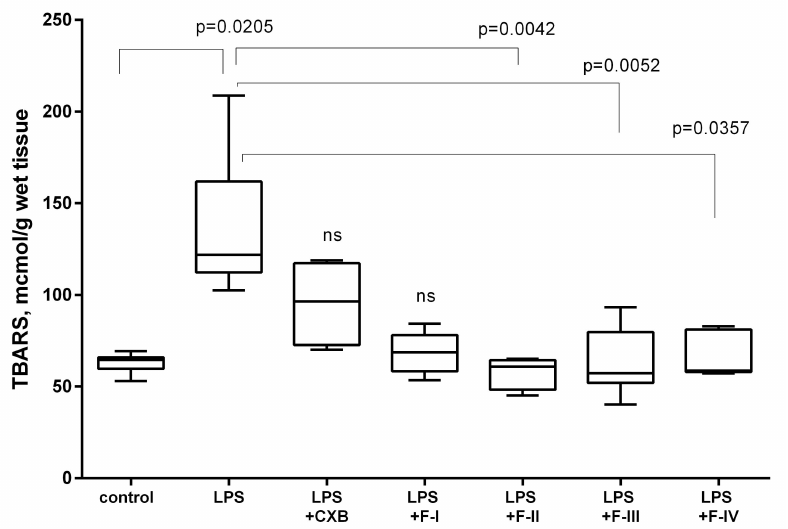
Figure 3. TBARS levels in mouse brain 72 h after LPS injection ( p -value of significance, ns means